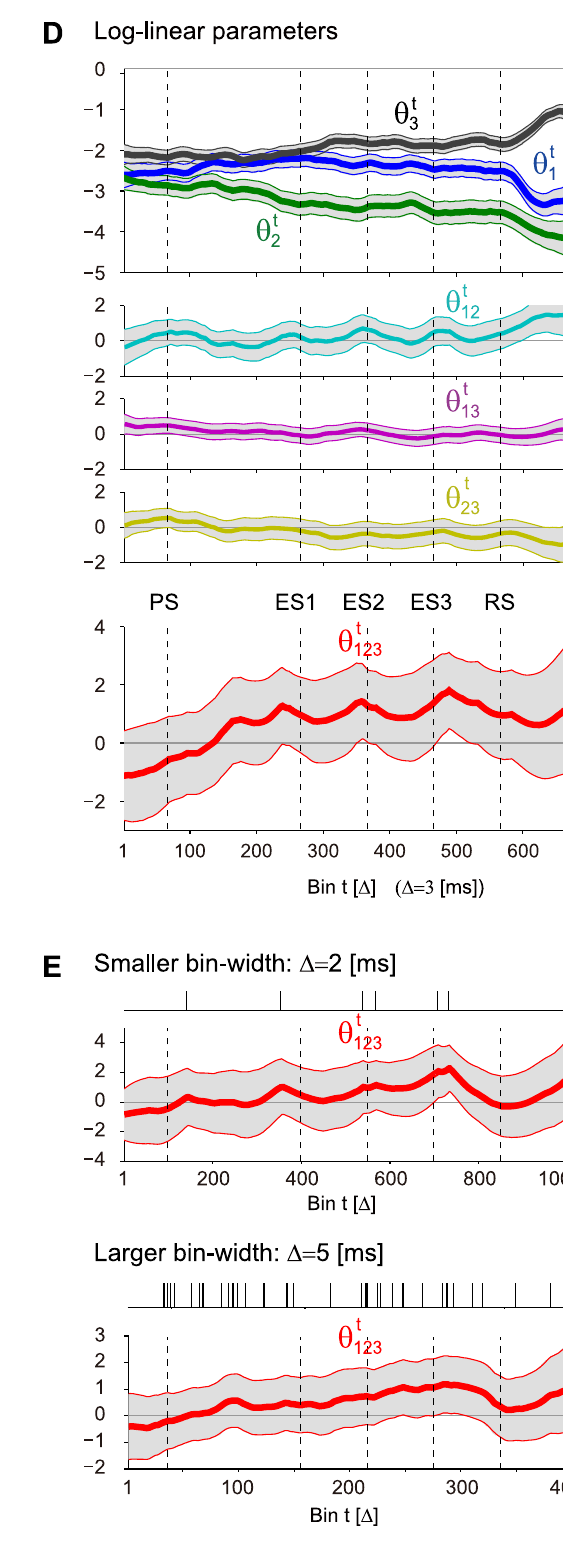
Figure 6. Analysis of experimental spike data using the state-space log-linear model. (A) Experimental time table of delayed-response hand movement task. The experiments were designed and conducted by Riehle and her colleagues [8,84]. During the preparatory period (PP, 1500 ms) that starts with the preparatory signal (PS), the presentation of the response signal (RS) was expected at three distinct moments at 600, 900, and 1200 ms (expected signals, ESs). Here the RS occurs finally after the longest possible delay of 1500 ms. After the RS, the requested movement was executed (reaction and movement time, RT-MT). See [8,84] and the text for the detailed experimental protocol. (B) Dot displays of the spike sequences (duration: 2 s, sampling resolution 1 ms) of three neurons simultaneously recorded from the primary motor cortex (MI). The spike